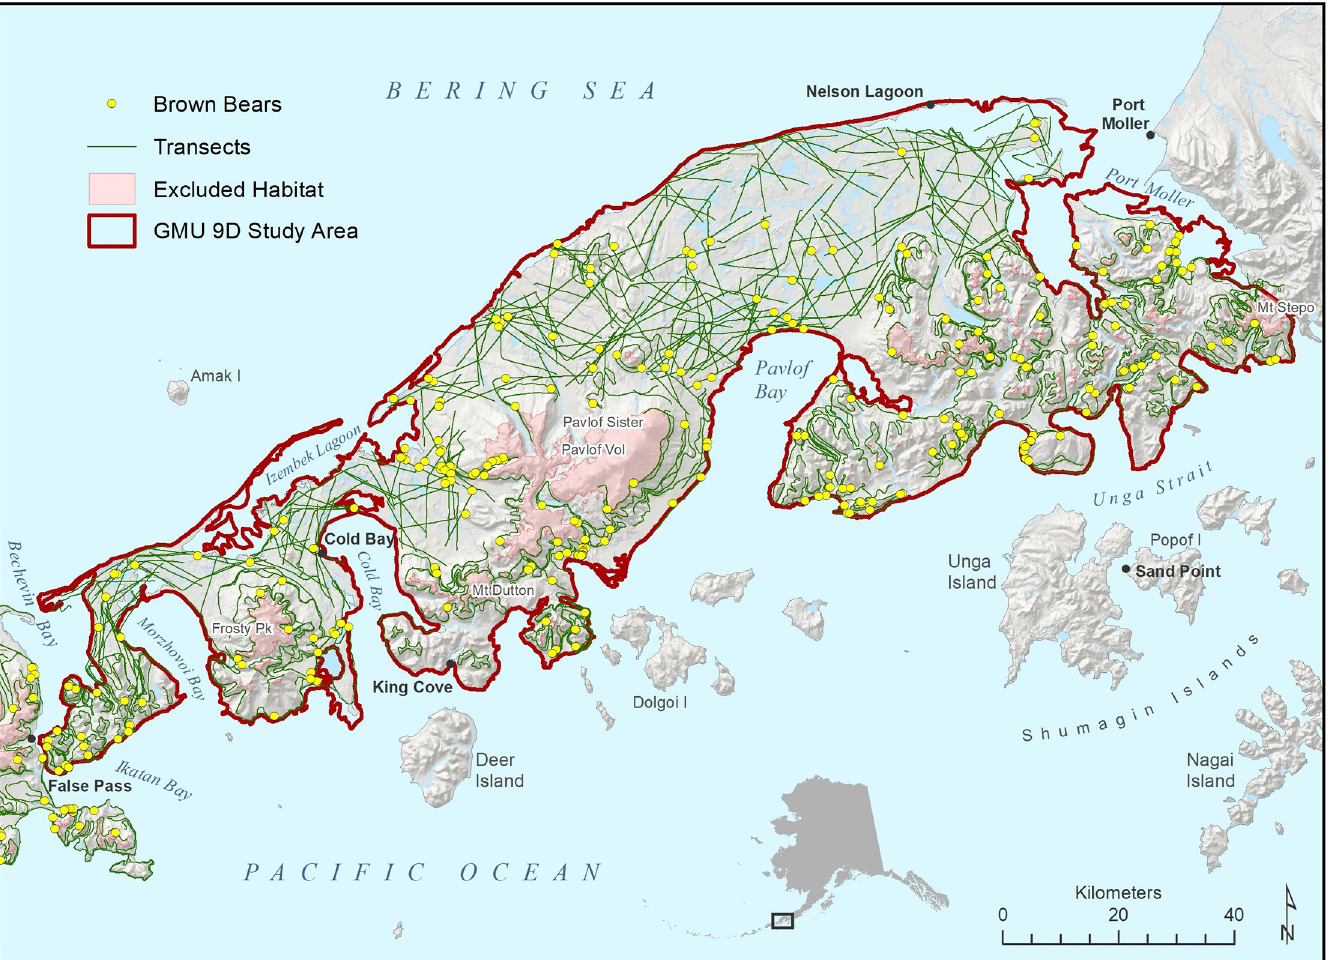
Fig 1. Game Management Unit 9D study area for a spring 2002 distance sampling survey of brown bears, Southern Alaska Peninsula, Alaska (U.S Geological Survey, National Hydrology Dataset https://www.usgs.gov/core-science-systems/ngp/national-hydrography/access-national-hydrography-products and the U.S. Geological Survey, National Elevation Dataset, http://ned.usgs.gov/). Note: Some transects are depicted in very shallow water and low tide mud flats, both of which brown bears use to harvest clams.